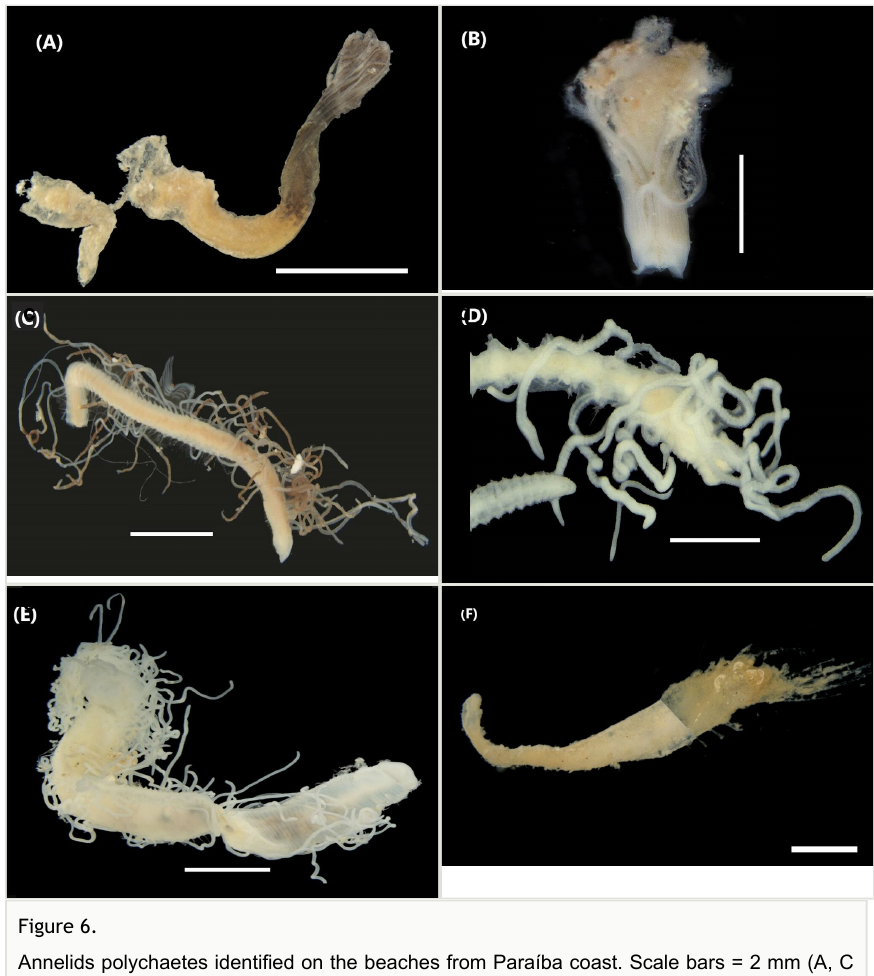
Figure 6. Annelids polychaetes identified on the beaches from Paraíba coast. Scale bars = 2 mm (A, C and E), 1 mm (B and F), 500 µm (D). Photos: (B) by Freitas, P.; (A and C-F) by Prata,